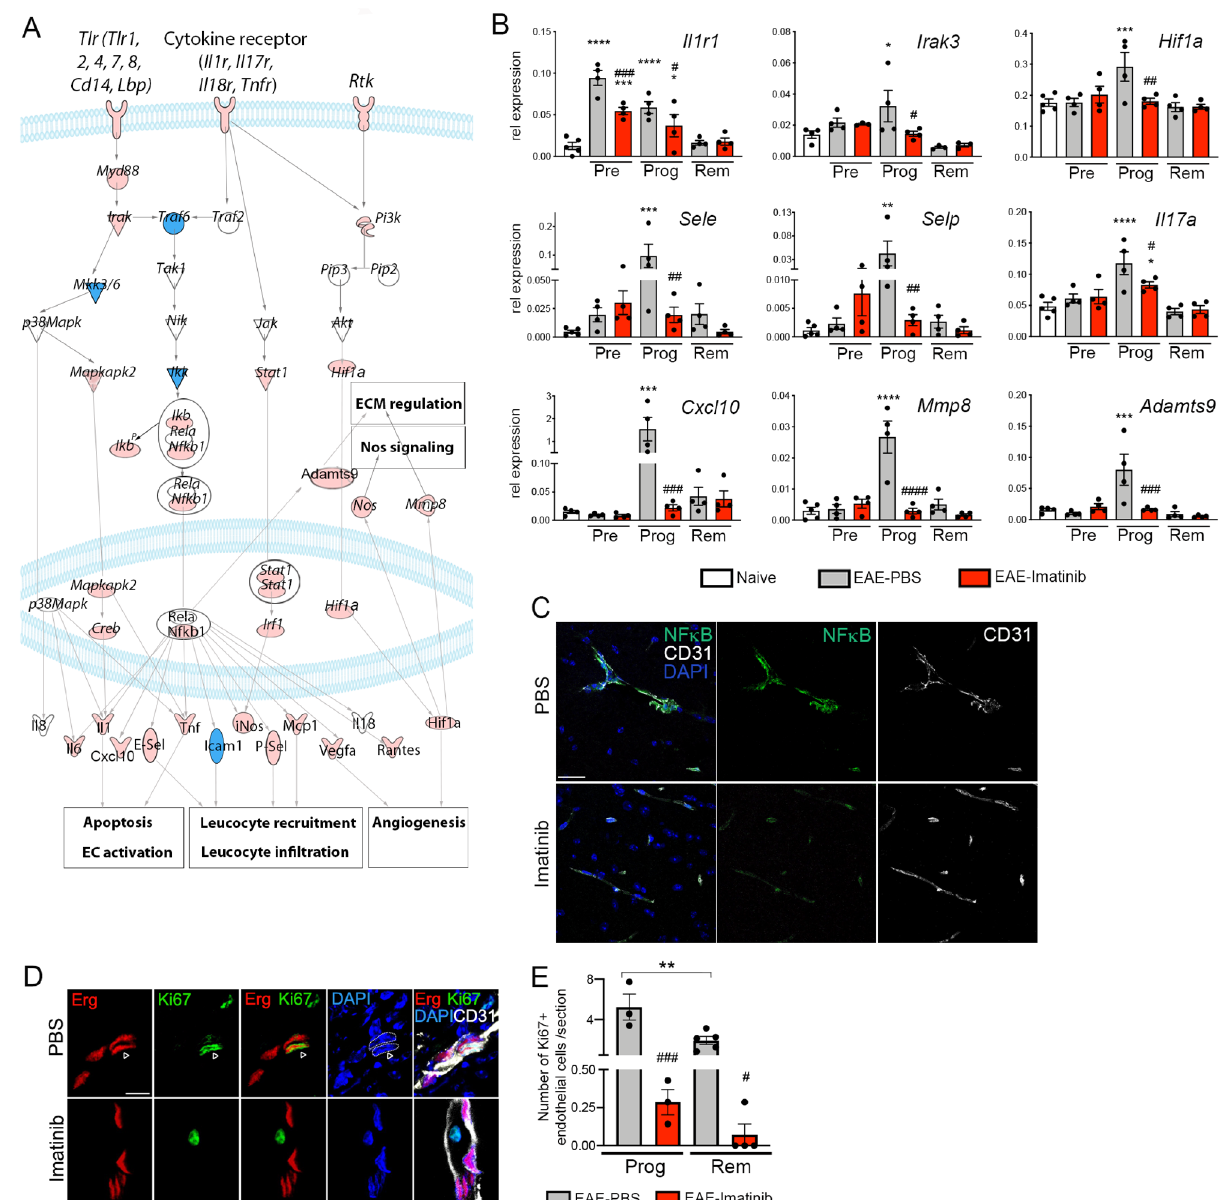
Figure 3. Blocking PDGFRα signaling down-regulates BBB transcripts important for endothelial cell activation and leucocyte recruitment. C57BL/6N mice were immunized with MOG to induce EAE, treated either with imatinib or PBS from day 2 p.i. until the end of the experiment and vascular fragments were isolated from the spinal cord at the preclinical, progression and remission phase. ( A ) Multi-pathway scheme generated by Ingenuity: During the progression phase, genes important for endothelial cell activation, leucocyte recruitment and infiltration, angiogenesis and extracellular matrix regulation are up-regulated via Mapk or NfkB downstream signaling activated by cytokine and toll-like receptors at the BBB. Molecules in pink indicate that these molecules are upregulated during the EAE progression phase and restored by imatinib treatment. Molecules in blue indicate that these molecules are upregulated during the EAE progression phase but not restored by imatinib treatment, whereas molecules in white are not regulated. ( B ) Quantitative real-time PCR analyses of vascular fragment cDNA from naïve and imatinib or PBS treated EAE induced mice collected at the preclinical, progression and remission phase (n = 4 mice for each treatment group for preclinical, progression and remission phase, n = 5 mice for naive mice). During the progression phase, imatinib significantly down-regulated all transcripts shown. ( C ) Representative images of NfκB p65 subunit expression (green) in spinal cord cross-sections showing expression in endothelial cells and infiltrating immune cells in PBS-treated EAE induced mice in the progression phase, indicative of an inflammatory response at the BBB. Imatinib-treated EAE induced mice exhibit less NfκB p65 immunoreactivity. Anti-CD31 co-staining in white. Scale bar, 20 μm. ( D ) Representative images of the nuclear proliferation marker Ki67 (green) co-stained with the endothelial cell transcription factor ERG (red) and CD31 (white) in spinal cord cross-sections show proliferating angiogenic endothelial cells during disease progression (arrowhead). ( E ) Quantification shows significantly less proliferating endothelial cells during disease remission, compared to progression phase, in the PBS-treated mice. Imatinib-treated mice show less endothelial proliferation during both phases. n = 3 and 4 mice for each treatment group of progression and remission phase, respectively. Results are depicted as mean ± SEM. Statistics were calculated using one-way ANOVA with Fisher´s LSD test and P values < 0.05 were considered significant (* ,# P < 0.05; ** ,## P < 0.01; *** ,### P < 0.001 and **** ,#### P < 0.0001). In B, * significance between naive and EAE PBS treated mice; # significance between EAE PBS and EAE imatinib treated mice. Abbreviations: Pre: preclinical phase, Prog: progression phase, Rem: remission